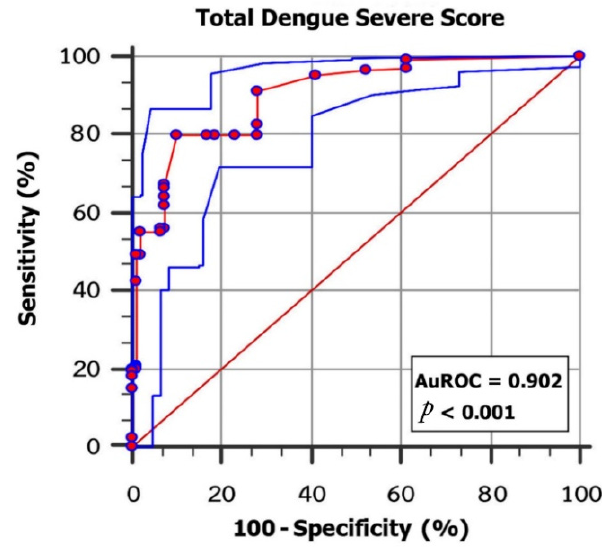
Figure 1 . The scoring system for the classification of severe and non - severe infections, with an area under the receiver operation curve (AUROC) of 0.902 (95% CI = 0.863 to 0.933).